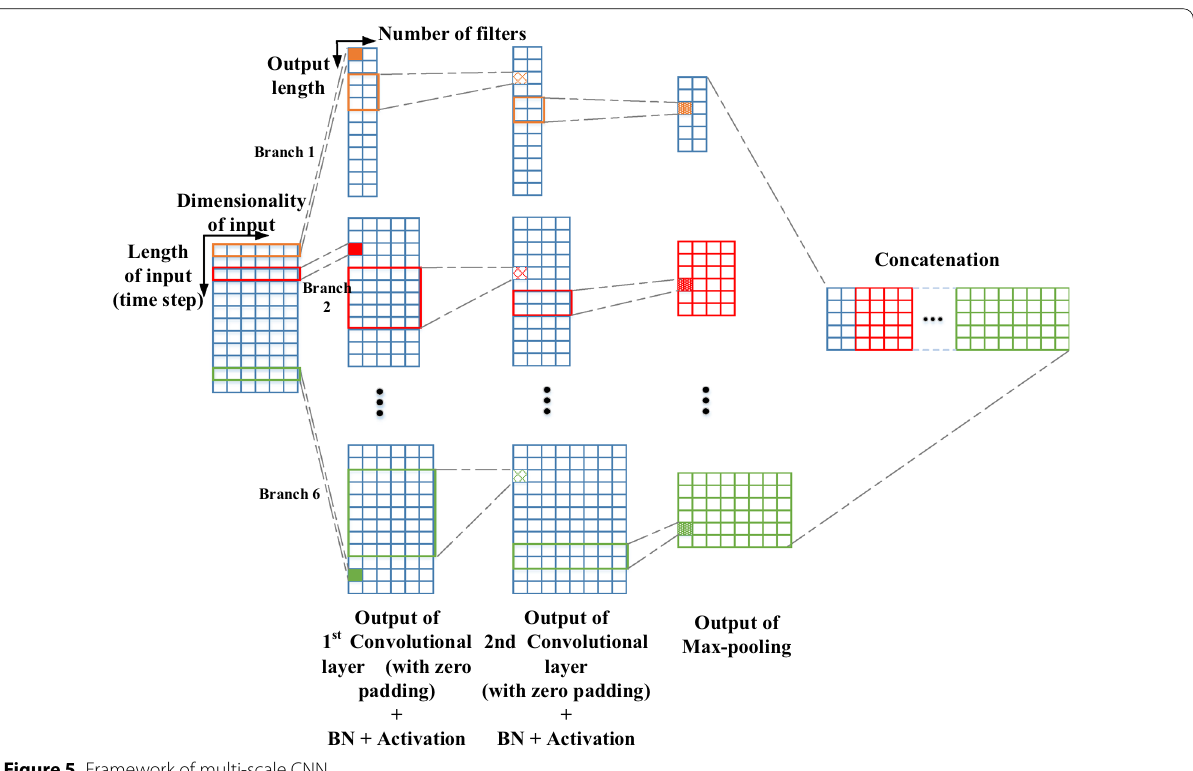
Figure 5 Framework of multi-scale